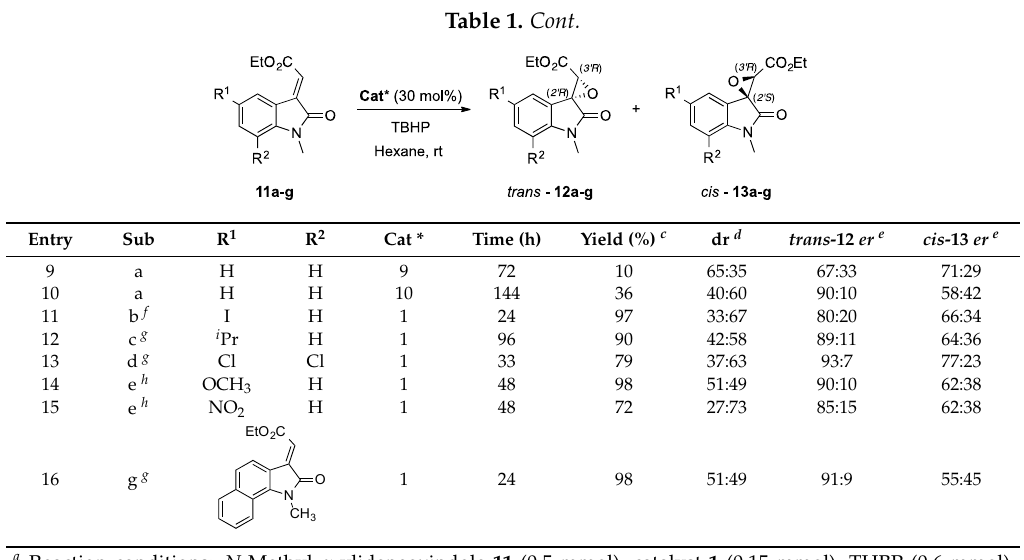
Table 1. Effect of selected organocatalyst ( 1 – 10 , Figure 1) on the asymmetric epoxidation of various N -methyl α -ylidene oxindoles ( 11a – g ) bearing a carboxylate (CO 2 Et) as electron-withdrawing group (EWG) on the exocyclic double bond a,b .